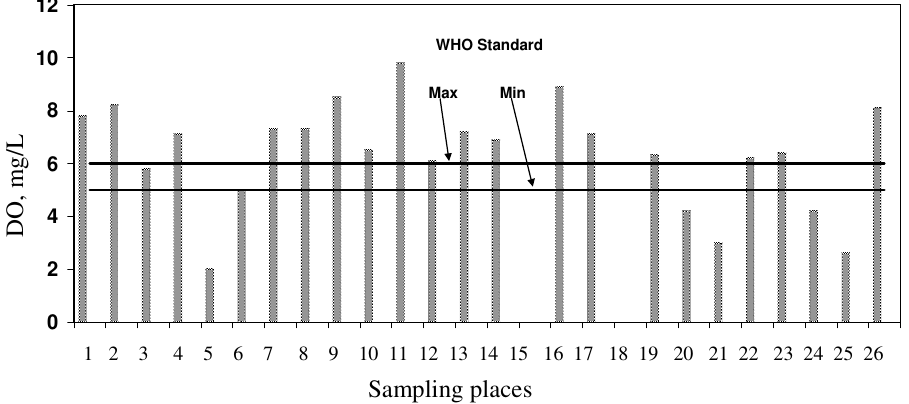
Figure 2. DO values of various water samples collected in and around Tiruppur